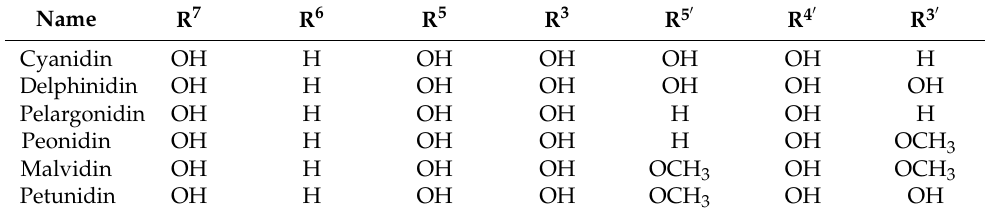
Table 1. Main types of anthocyanidins.